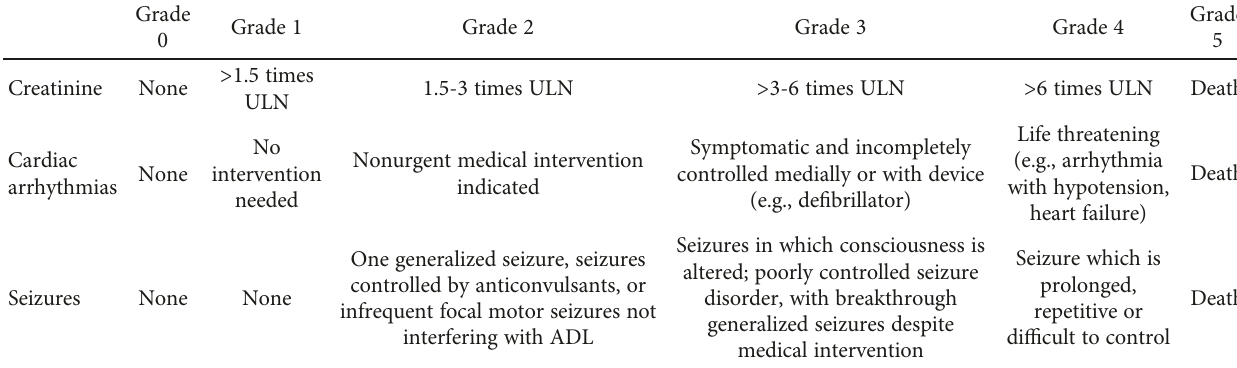
Table 3: Cairo-Bishop clinical tumor lysis syndrome